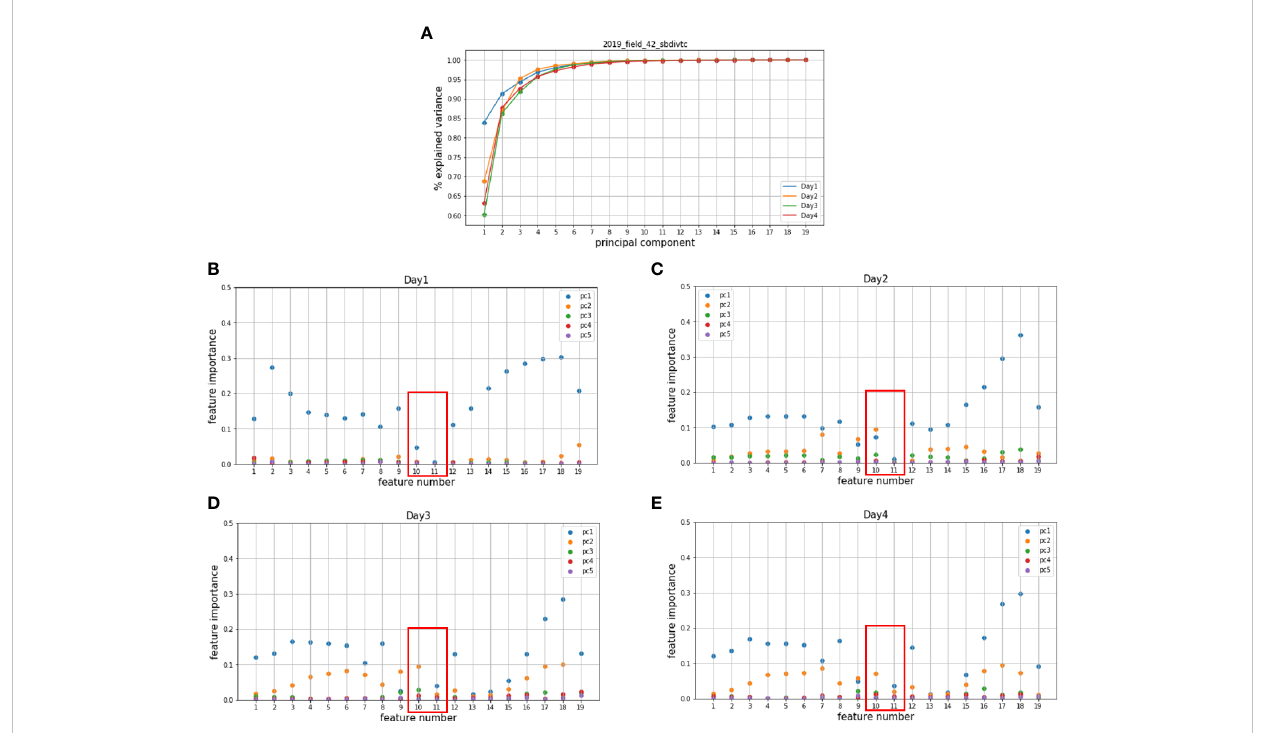
FIGURE 8 Principal components of the LiDAR features in (A) 2019 Tc panel and the corresponding importance of all LiDAR features on (B) 1st, (C) 2nd, (D) 3rd, (E) 4th dates which represents 4 different growing